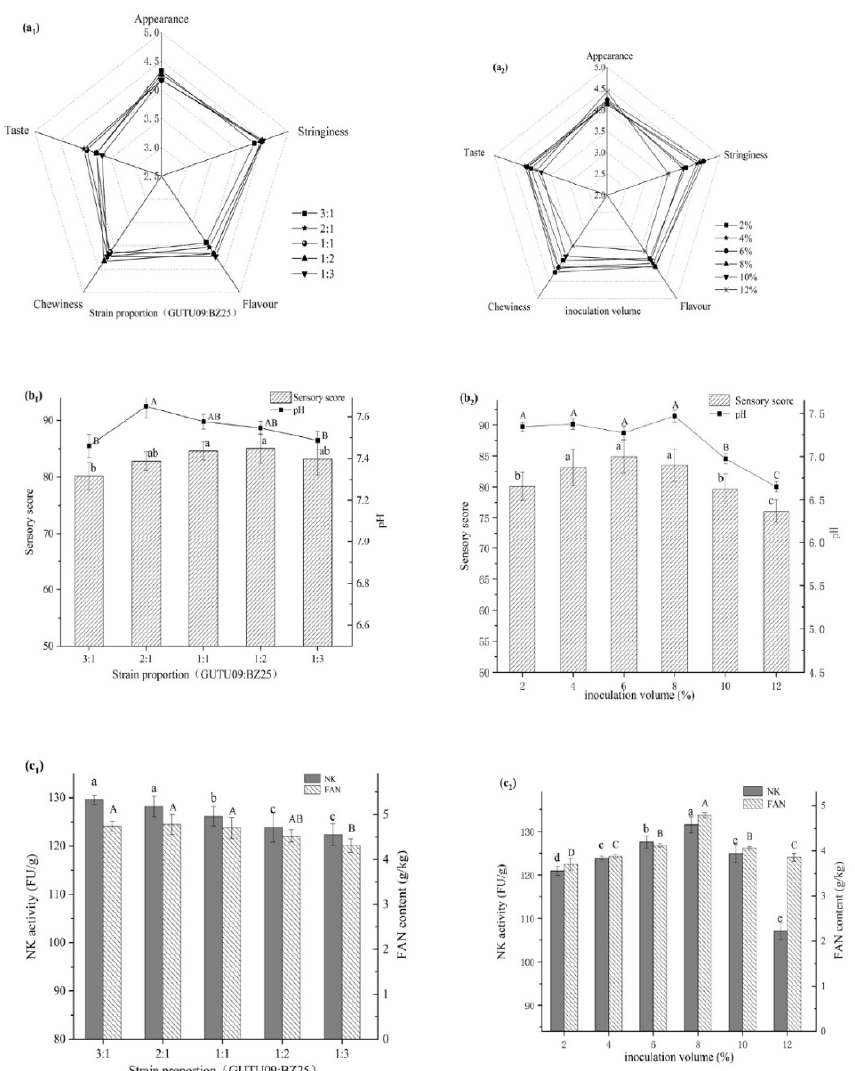
Figure 2. Effects of strain proportion ( a 1 , b 1 , c 1 ) and inoculation volume ( a 2 , b 2 , c 2 ) on natto fermenta-